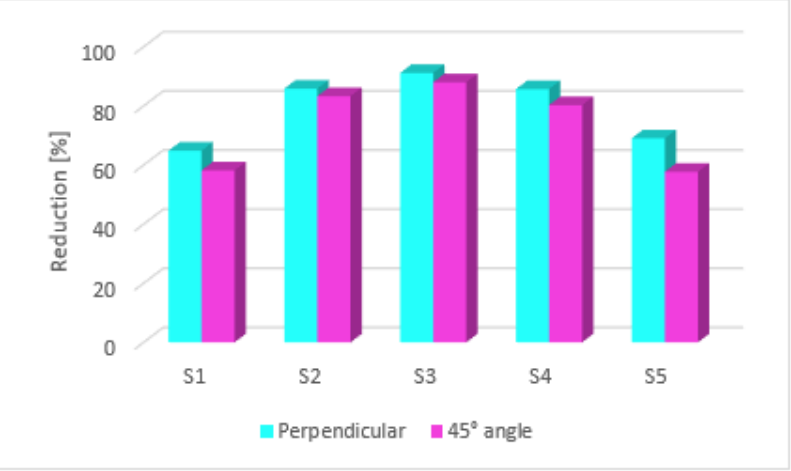
Figure 7. Roughness reduction at 90° and 45° angle after laser polishing post ‐ processing.